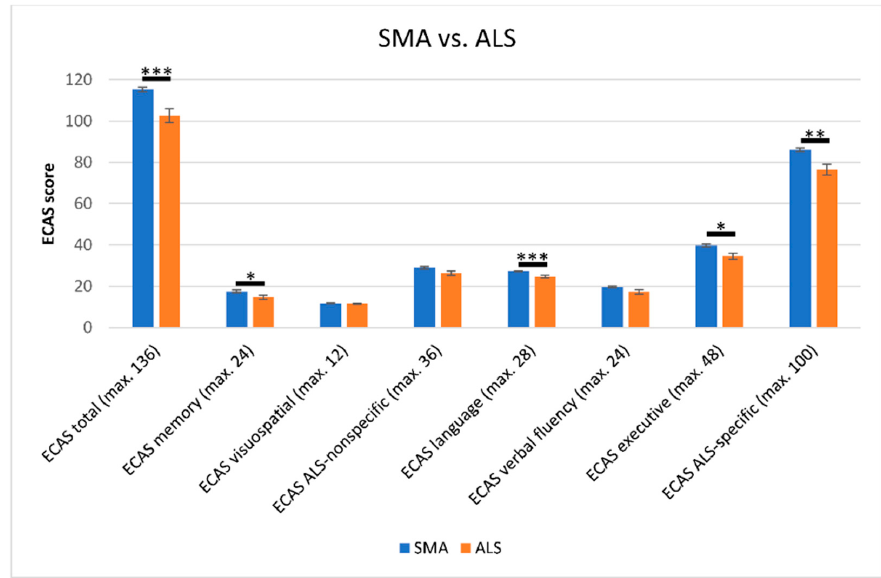
Figure 2. Comparison of cognitive scores according to the Edinburgh Cognitive and Behavioural ALS Screen (ECAS) in SMA and ALS patients. SMA patients scored significantly higher in the ECAS in total score, as well as in the subdomains of memory, language, executive and the ECAS ALS-specific subscores. No significant differences between both groups were detected in the ECAS visuospatial (mean 11.7 vs. 11.5; U = 512.0, Z = 1.016, p = 0.310, r = 0.12) and verbal fluency subdomains (mean 19.7 vs. 17.2; U = 431.0, Z = 1.684, p = 0.092, r = 0.21), or in the ECAS ALS-nonspecific subscore (mean 28.9 vs. 26.2; U = 424.5, Z = 1.889, p = 0.059, r = 0.23). Significance levels: * p ≤ 0.05, ** p ≤ 0.01, *** p ≤ 0.001. Effect sizes of r = 0.10, r = 0.30, and r = 0.50 served as thresholds for small, medium and large effects [30], respectively. Abbreviations: SMA, Spinal Muscular Atrophy; ALS, Amyotrophic Lateral Sclerosis; ECAS, Edinburgh Cognitive and Behavioural ALS Screen; max.,